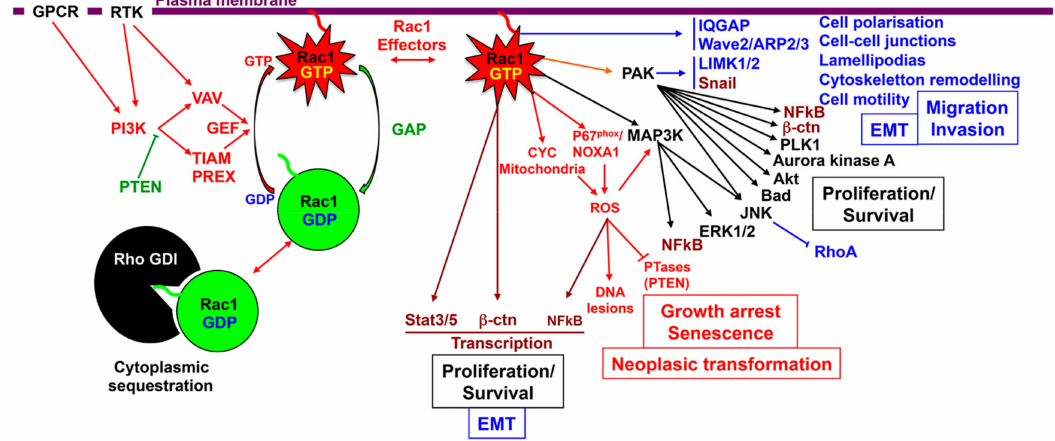
Figure 2. Schematic representation of Rac1 signaling pathways and their biological significance. Rac1 upstream regulators: the Rac1 activating and inhibitory pathways are represented in red and in green respectively. Rac1 interacting partners and downstream e ff ectors: transcription factors are represented in brown, e ff ector molecules in black, pathways involved in cytoskeleton remodeling and cell migration in blue, and ROS pathway in